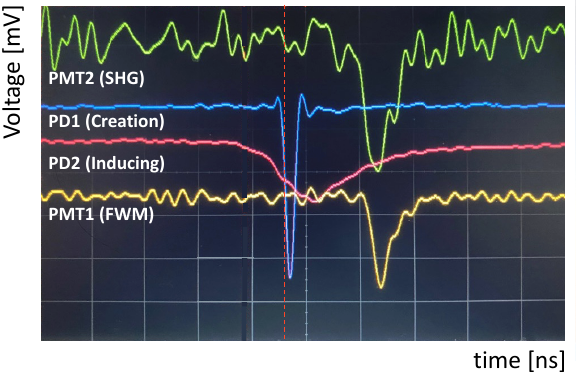
Figure 4. Photograph of oscilloscope waveforms from the four photodetectors in Figure 2. Four-wave mixing (FWM) photons were clearly observed when a thin BBO crystal was positioned at IP.